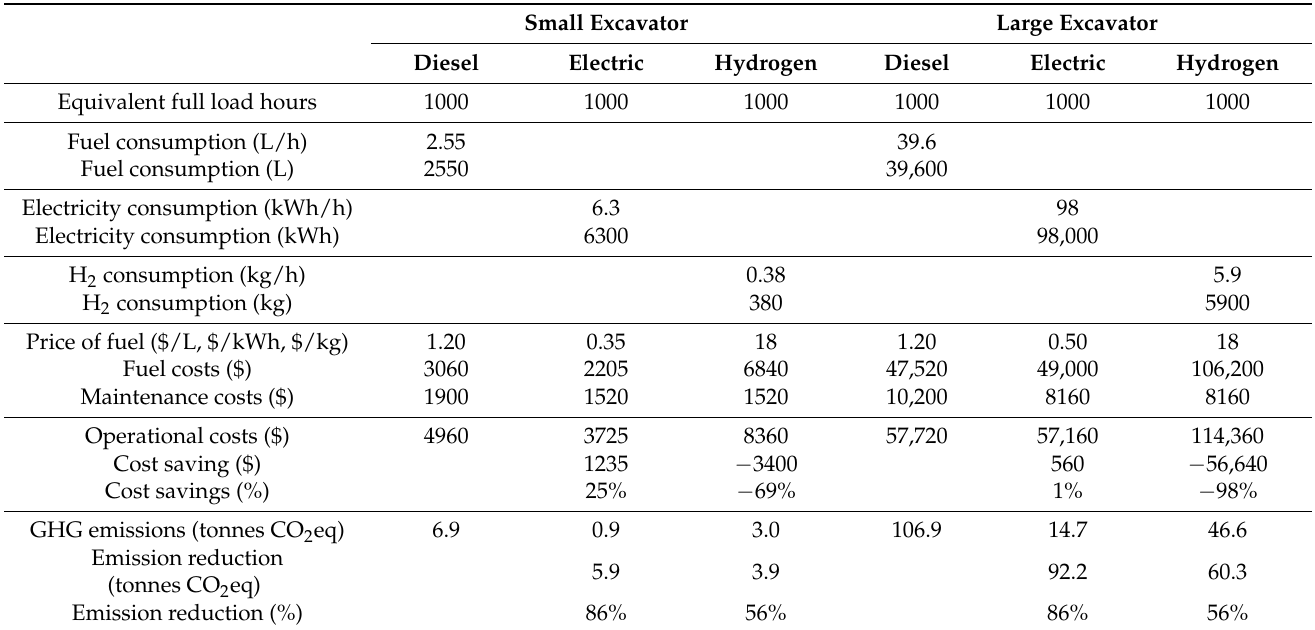
Table 7. Annual results (if not specified differently) for diesel, electric and hydrogen fuel cell excavator variants (per vehicle).